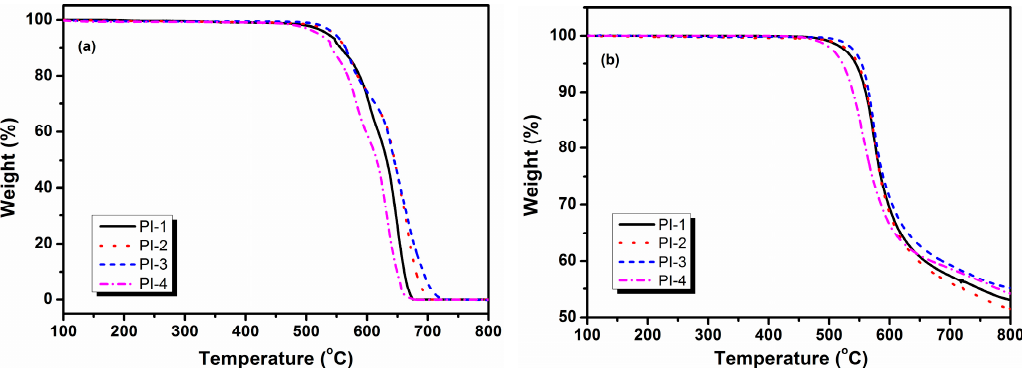
Figure 1. TGA curves of polyimides: ( a ) in Air; ( b ) in N 2 .